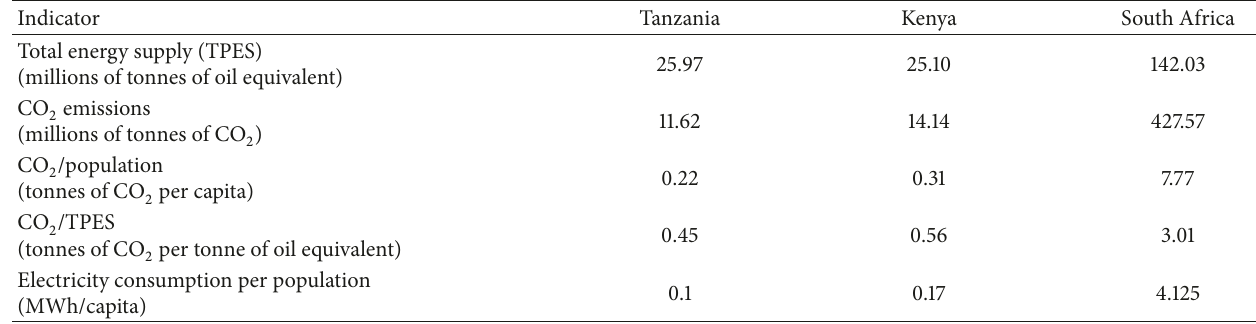
Table 1: Key energy indicators statistics for 2015.